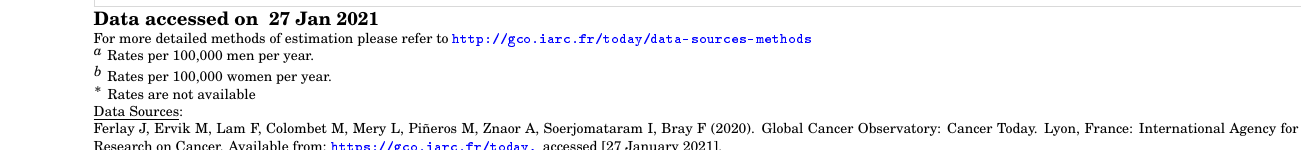
0.3 0 0.3 Anal cancer: Age standardised incidence rate per 100,000 men and women World Standard. Male and Female